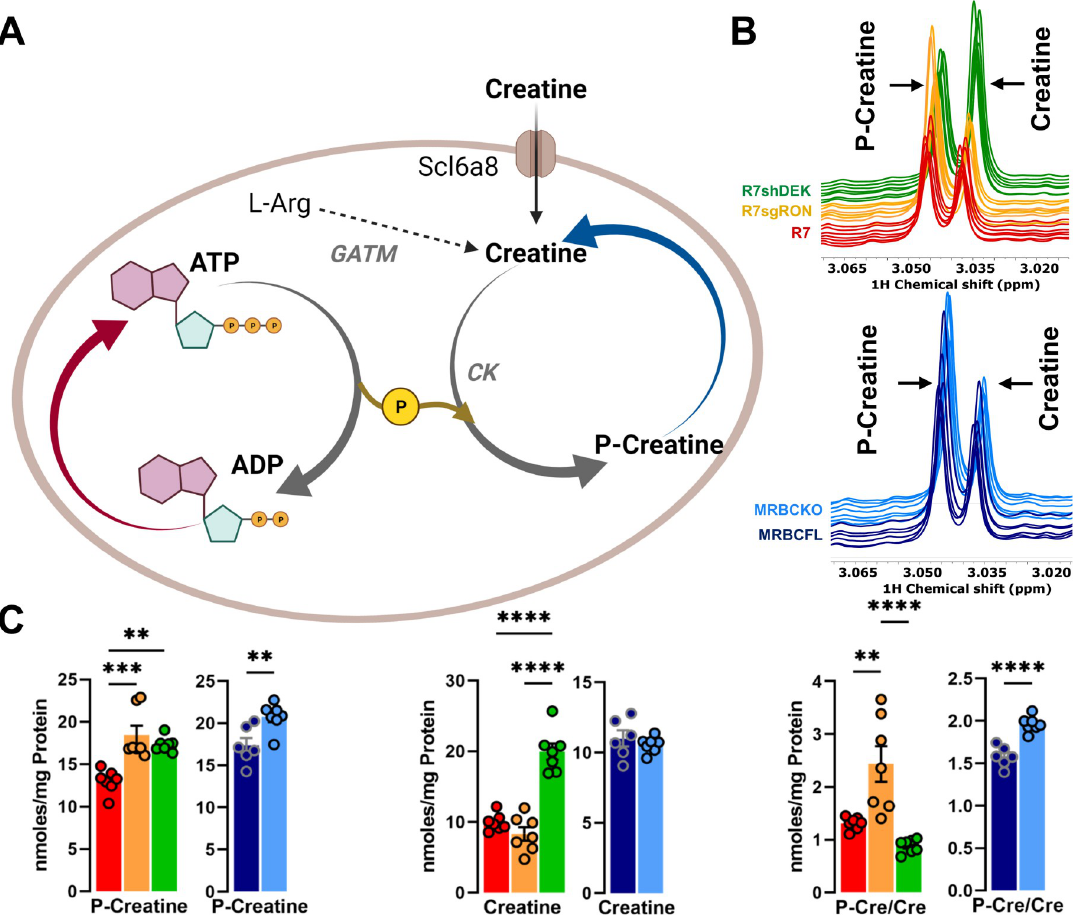
Fig 4. Creatine dynamics modulation by the RON-DEK- β -catenin axis. ( A ) Schematic of creatine dynamics (created with BioRender. com) illustrating the trends of R7 (red), R7sgRON (orange), R7shDEK (green), MRBC FL (dark blue), and MRBC KO cell lines (light blue). ( B ) Representative 1 H-NMR spectra of phospho-creatine (p-creatine) and creatine for R7, R7sgRON, and R7shDEK (top) and MRBC FL and MRBC KO (bottom) samples. ( C ) Intracellular levels of p-creatine, creatine, and p-creatine/creatine ratios. Bar graphs indicate mean and the error bars represent SEM of replicates. Replicates of each cell line are shown as individual dots (n = 6–7). Statistical significance was assessed using one-way ANOVA two-tailed Student’s t-test for R7 and MRBC comparisons, respectively. � P � 0.05; �� P � 0.01; ��� P � 0.001; ���� P � 0.0001. survival (RFS) and distant metastasis-free survival (DMFS) data from Gene Expression Omni- bus (GEO)-derived datasets. Individual genes within each pathway signature and combined pathway signature prognostication for glycolysis and glycosylation ( S6 Fig ), TCA/anaplerosis ( S7 Fig ), NAD + /Kynurenine and NAD + salvage ( S8 Fig ), and creatine ( S9 Fig ) is shown with respective p -values input for FDR procedure (5% cutoff) with the multiple testing [24] webtool as evident in Tables 1 and 2 .